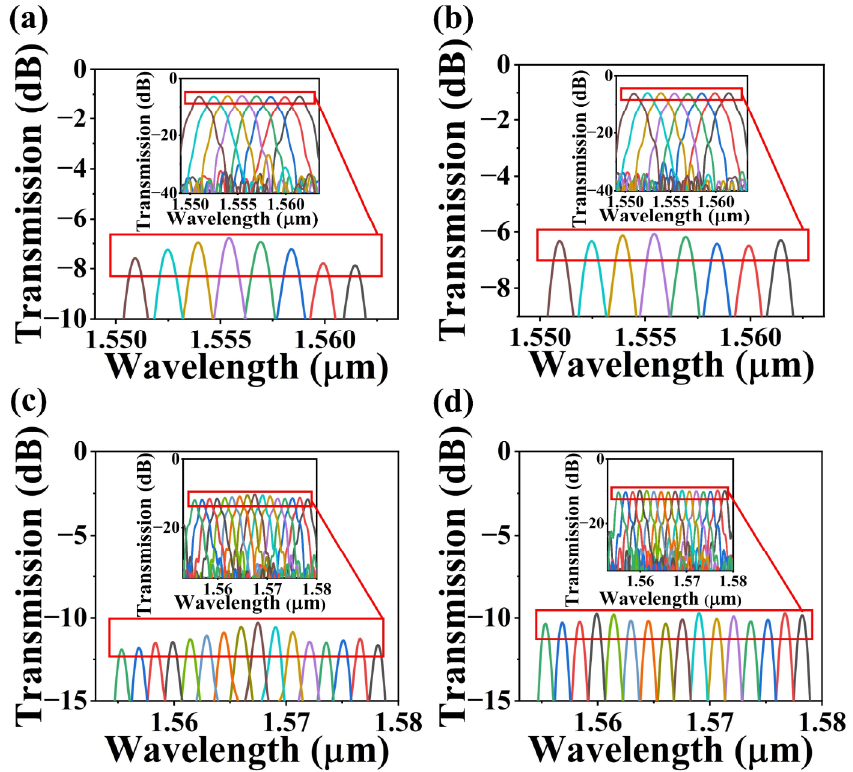
Figure 6. Simulated partial transmission spectra with the conventional and the uniformity-improved structure for ( a , b ) 8 and ( c , d ) 16-channel AWG. Inset: Simulated complete transmission spectra.